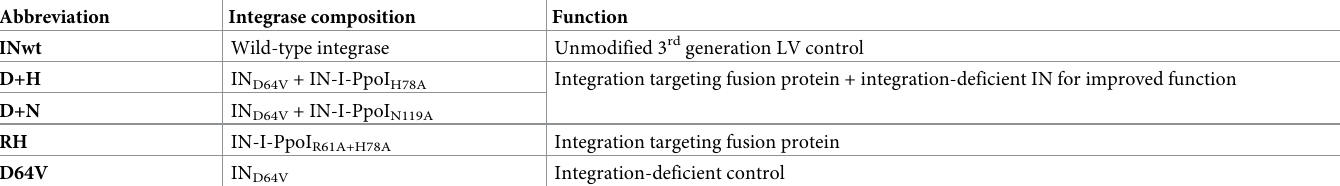
Table 2. Description of the integrase compositions of the LVs used in this